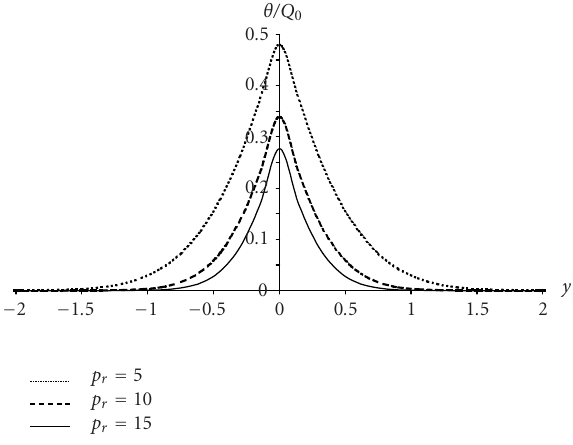
Figure 7.1. The temperature distribution for di ff erent values of p r for the whole-space problem.